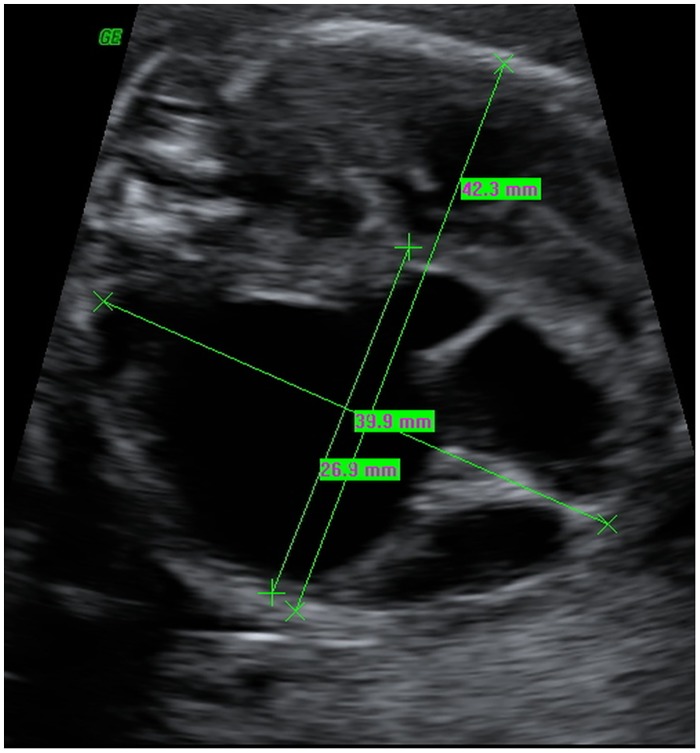
Transverse section of the fetal thorax at 19 weeks of gestation demonstrating a large macrozystic congenital pulmonary airway malformation (CPAM) with severe mediastinal shift.MTR (Mass-to-thorax ratio): 26.9 / 42.3 = 0.63.